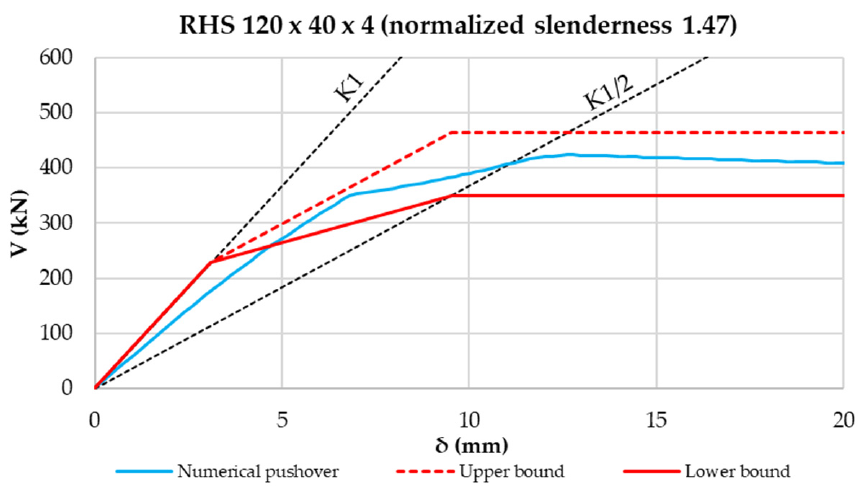
Figure 15. Comparison between analytical pushover curves and numerical one for the profile RHS 120 × 40 × 4. Some like “x” means “×”.